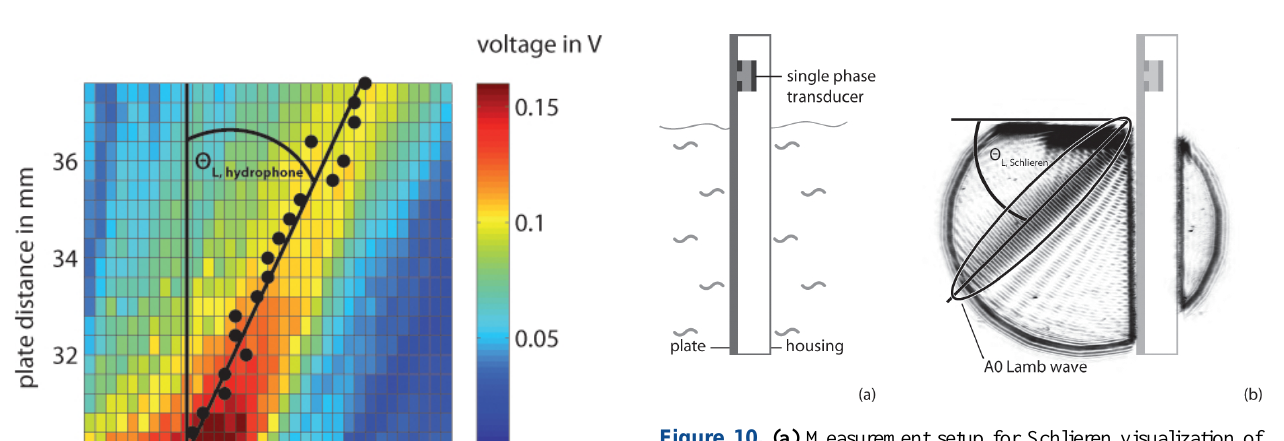
Figure 10. (a) Measurement setup for Schlieren visualization of Lamb wave emission. (b) Emission profile of acoustic wave excited by a single-phase transducer on a 1mm-thick glass